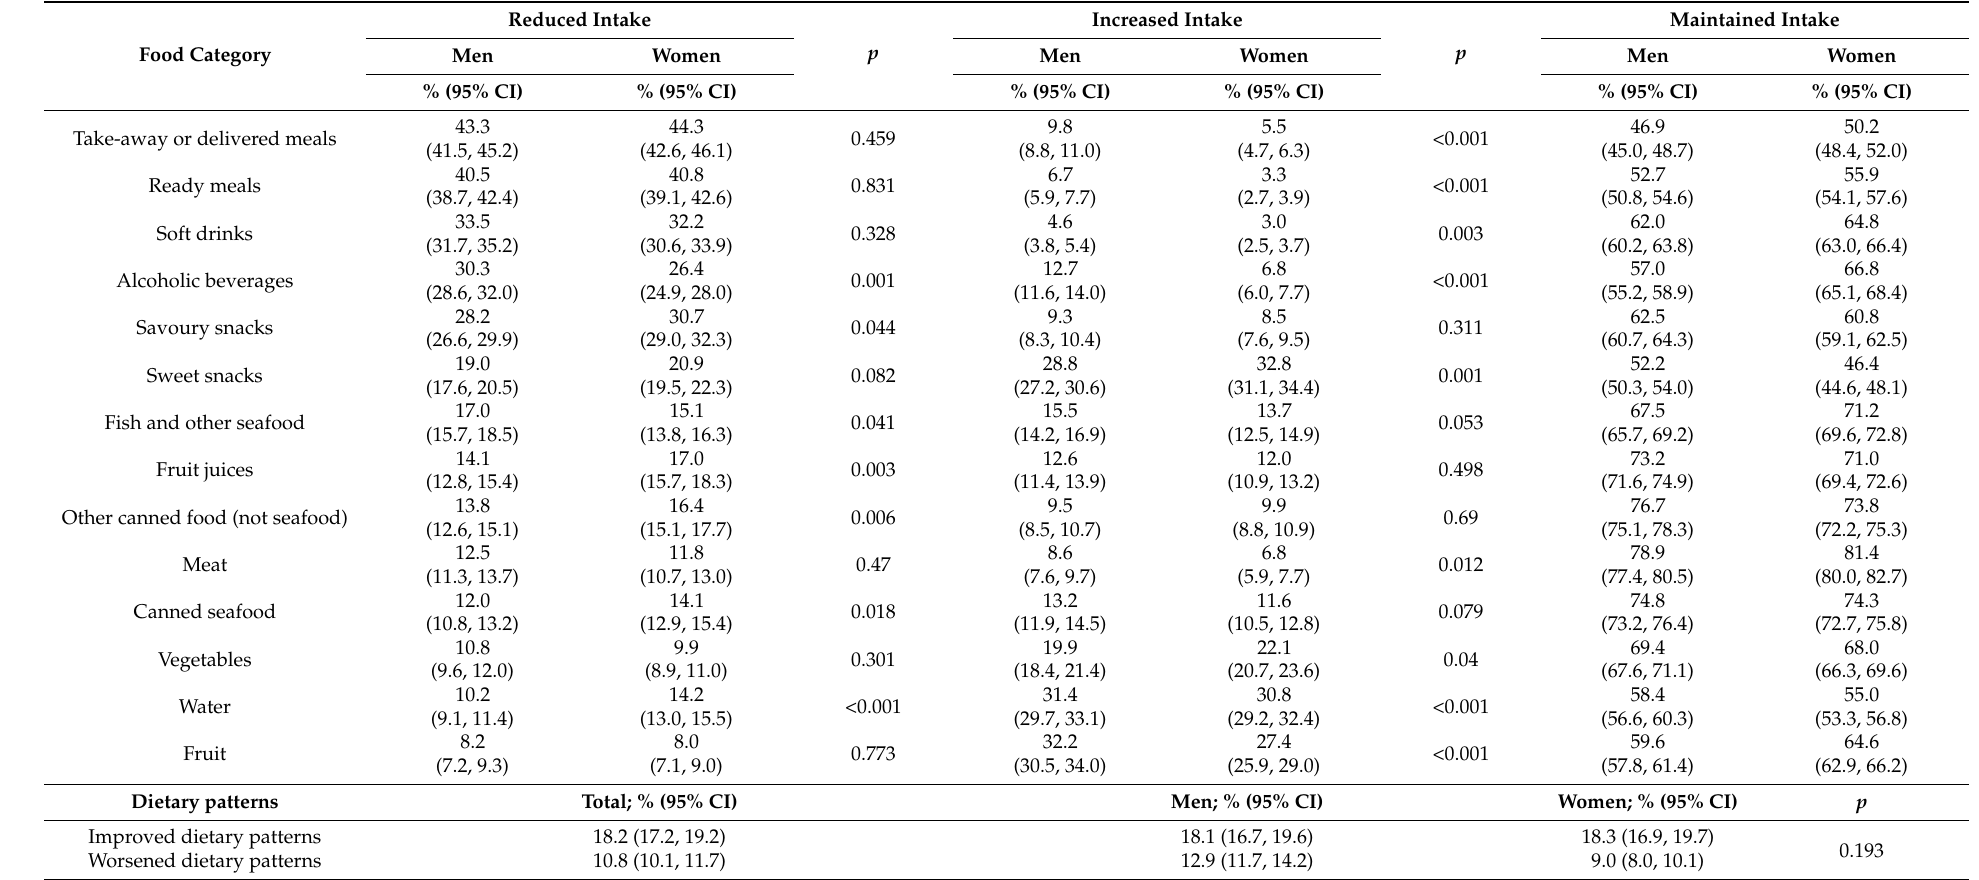
Table 5. Variation in food intake during COVID-19 social confinement by